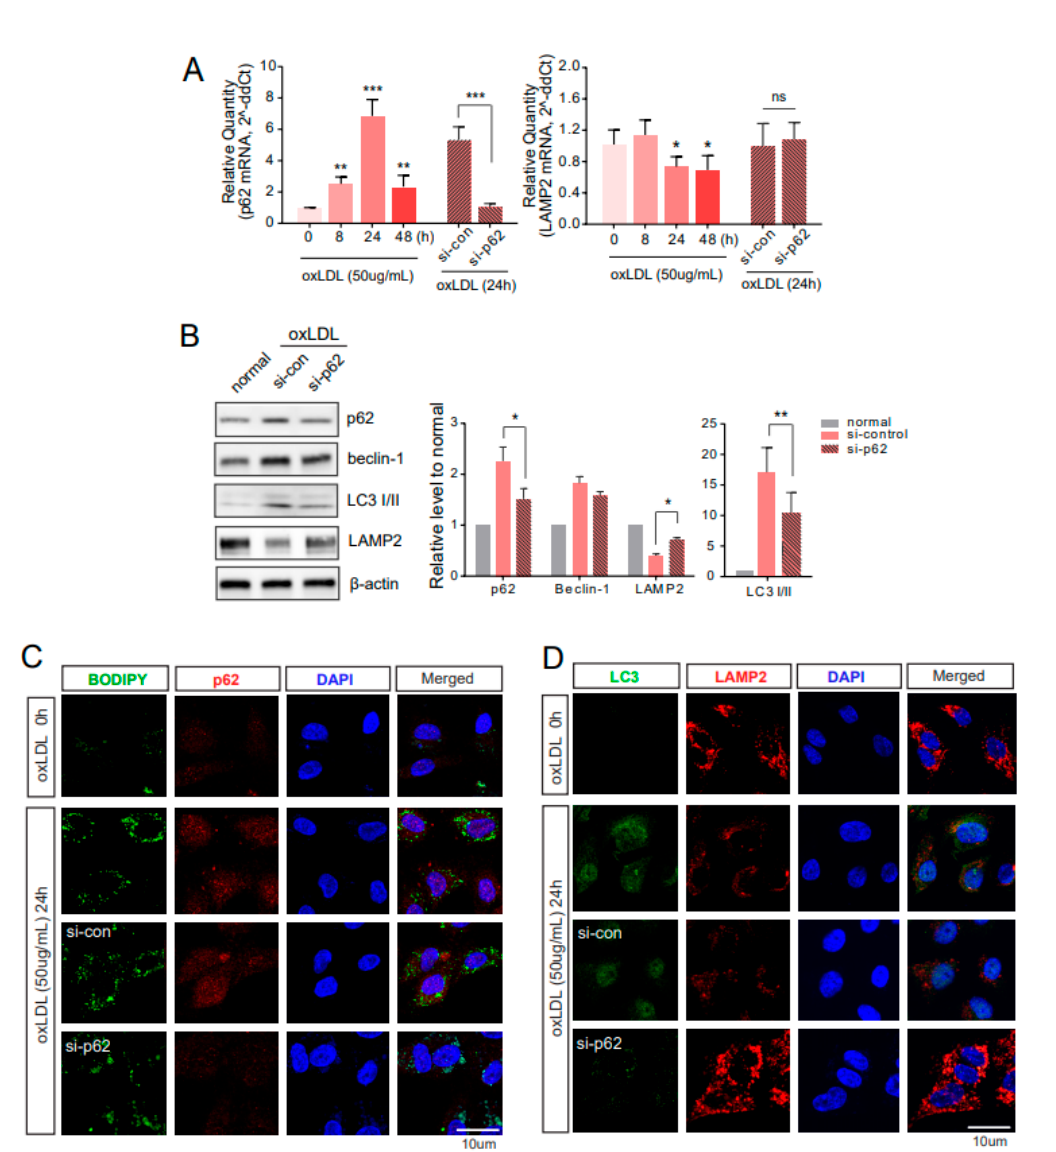
Figure 3. Autophagic dysfunction in HUVECs by downregulated p62. ( A ) Under atherosclerotic conditions derived by oxLDL exposure, the mRNA levels of p62 and LAMP2 were measured by real-time quantitative PCR. ( B ) After treatment with si-p62 for 24 h, cells were subsequently exposed to oxLDL for 24 h. The protein levels of each molecule were analyzed by western blotting (left), then quantified (right). ( C ) The consequences of downregulating p62 were evaluated with BODIPY staining for intracellular lipid and immunocytochemistry for p62. ( D ) Double-immunocytochemistry of LC3 and LAMP2 was done in si-p62 treated HUVECs under oxLDL exposure. ns, no significance; *, p < 0.05; **, p < 0.001, ***, p < 0.0001.